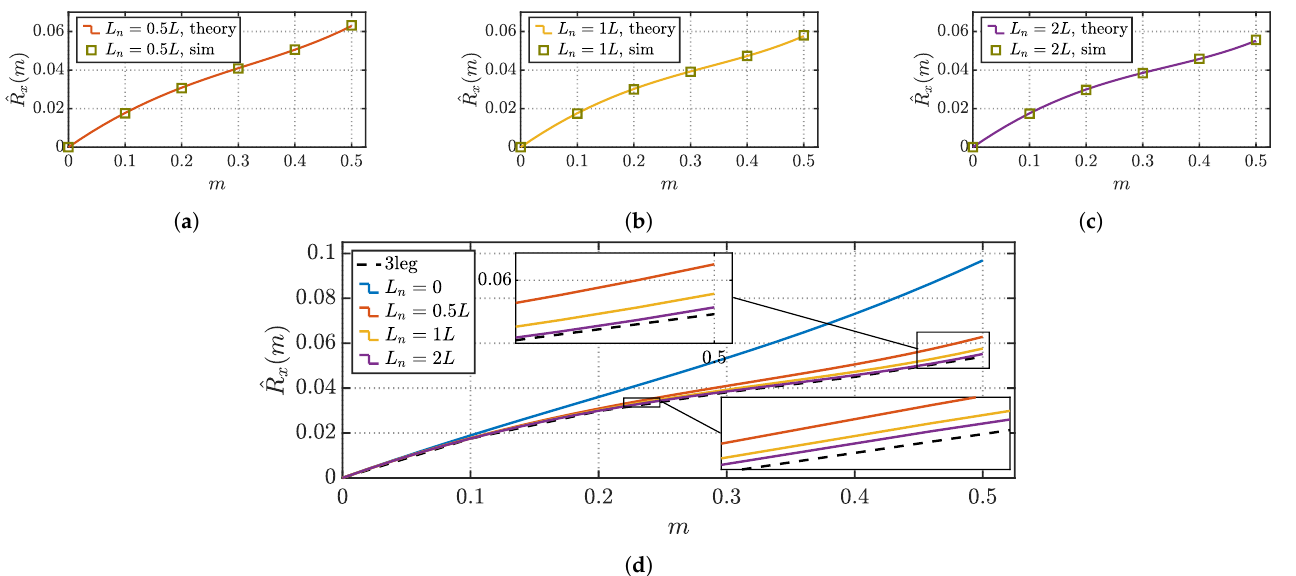
Figure 9. Normalized, theoretical RMS value of phase switching current ripple as a function of modulation index m along their corresponding simulation counterparts ( a ) k = 0.5, ( b ) k = 1, and ( c ) k = 2 and ( d ) a comparison of the normalized RMS of a phase switching current ripple.